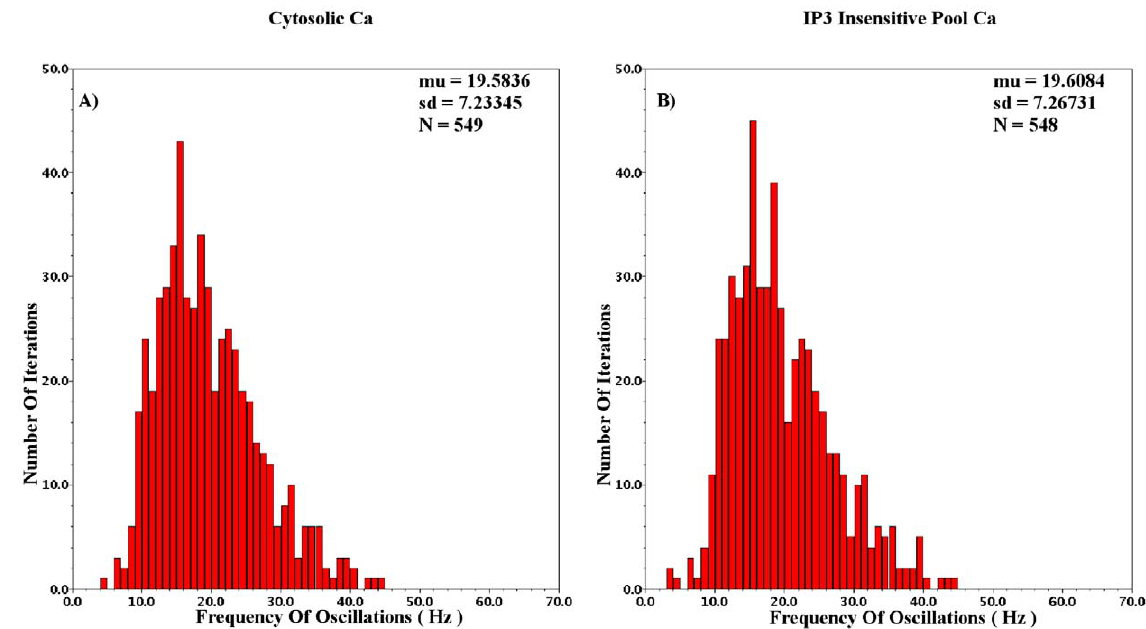
Figure 20. Monte Carlo Analysis for m ~ n ~ 2, p ~ 4 intracellular Ca 2 + Log-Domain circuit. 600 iterations have been performed, leading to a percentage greater than 90 % regarding successful oscillation runs.